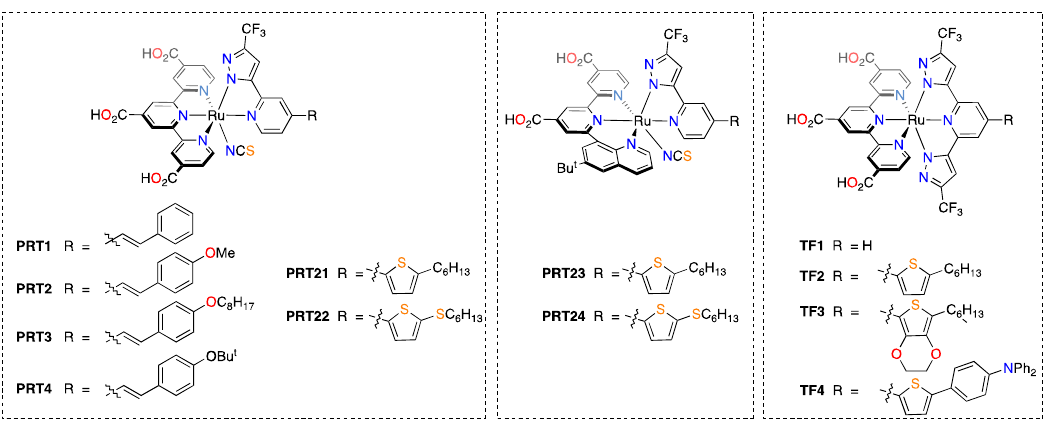
Figure 11. Selected PRT and TF series sensitizers with bidentate and tridentate ligands.